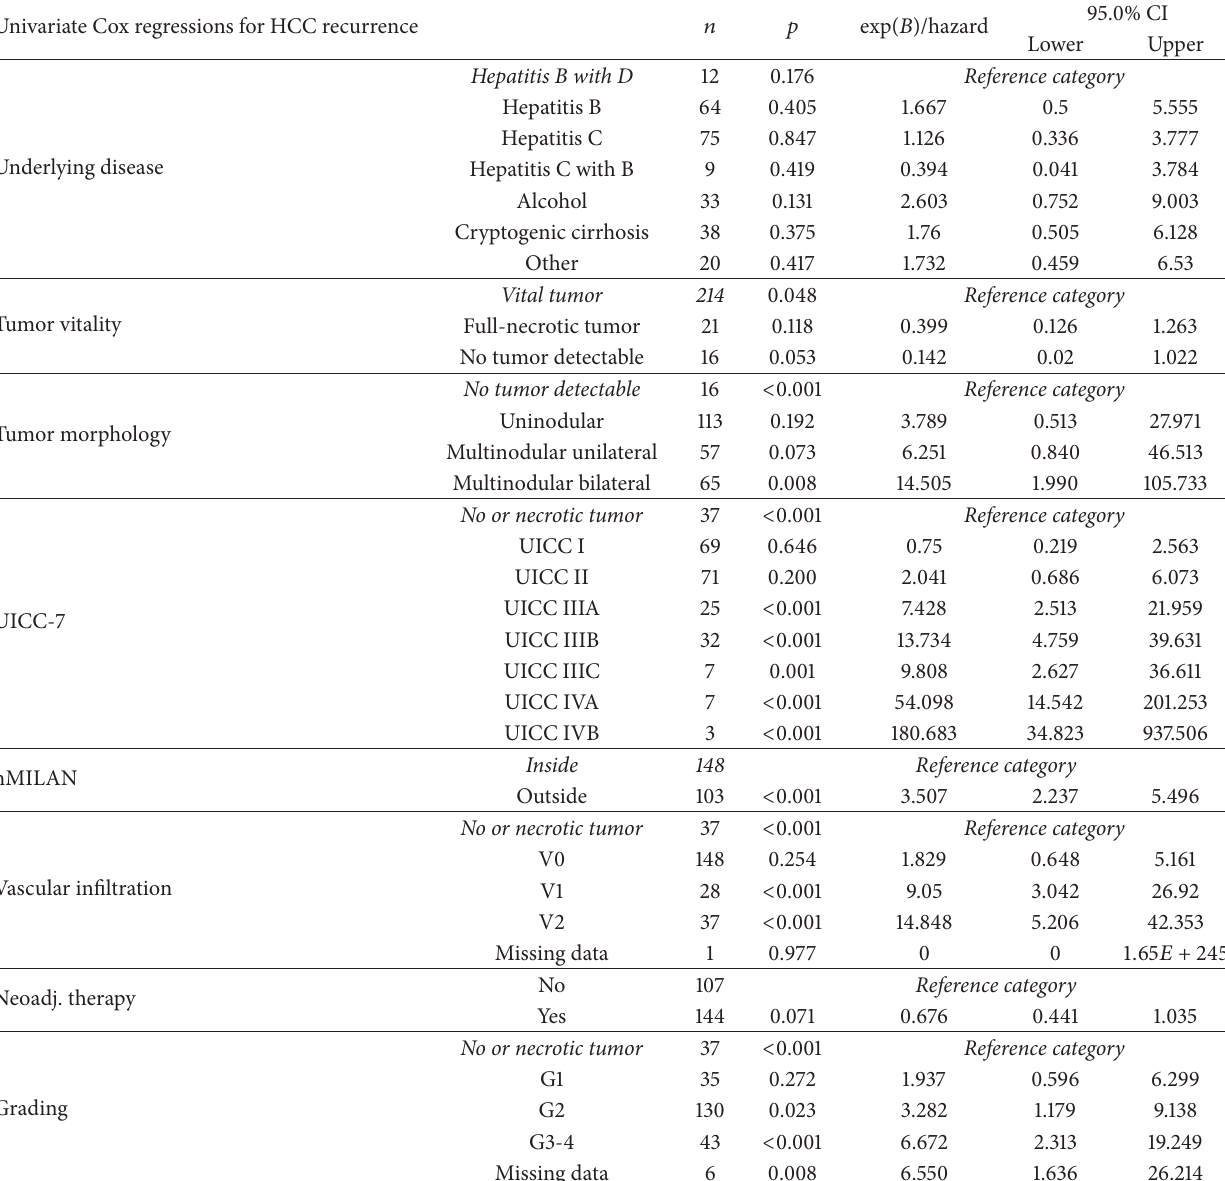
Table 5: Identification of hazards for HCC recurrence by univariate Cox regression, 𝑛 = 251 (hospital deaths excluded). Univariate Cox regressions for HCC